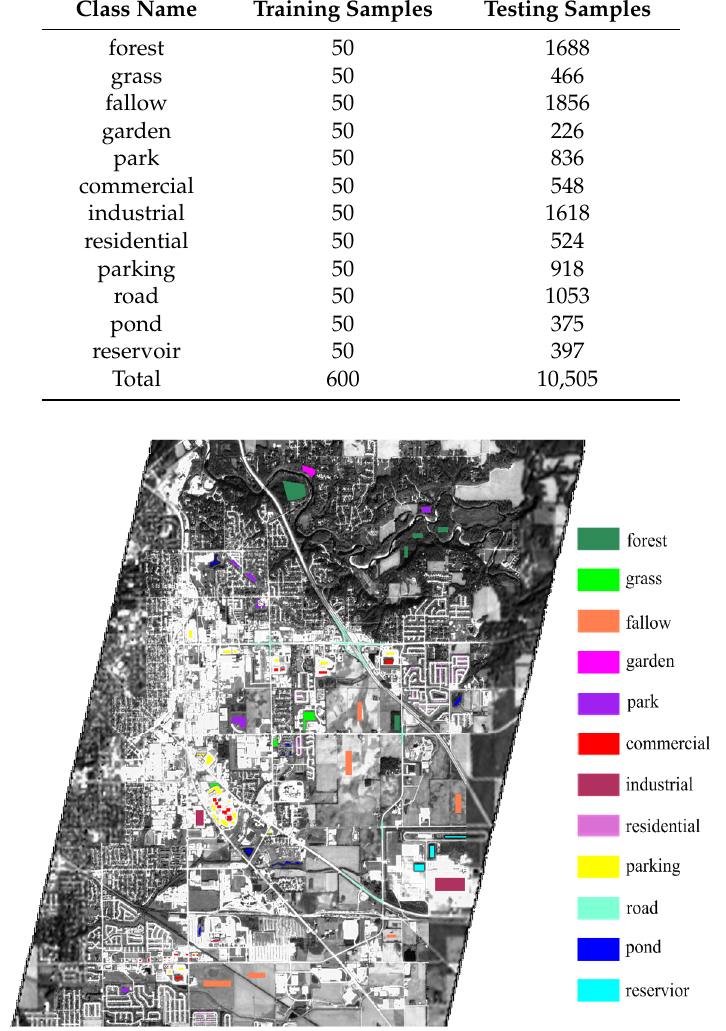
Figure 13. The ground truth labeled from each class. Table 7. The Overall Accuracy (OA) of different fusion results.